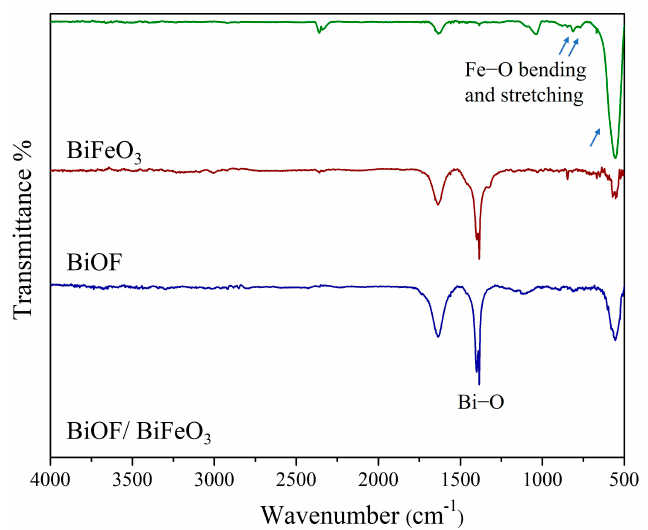
Figure 4. FTIR spectra of the prepared photocatalysts with corresponding band assignments.